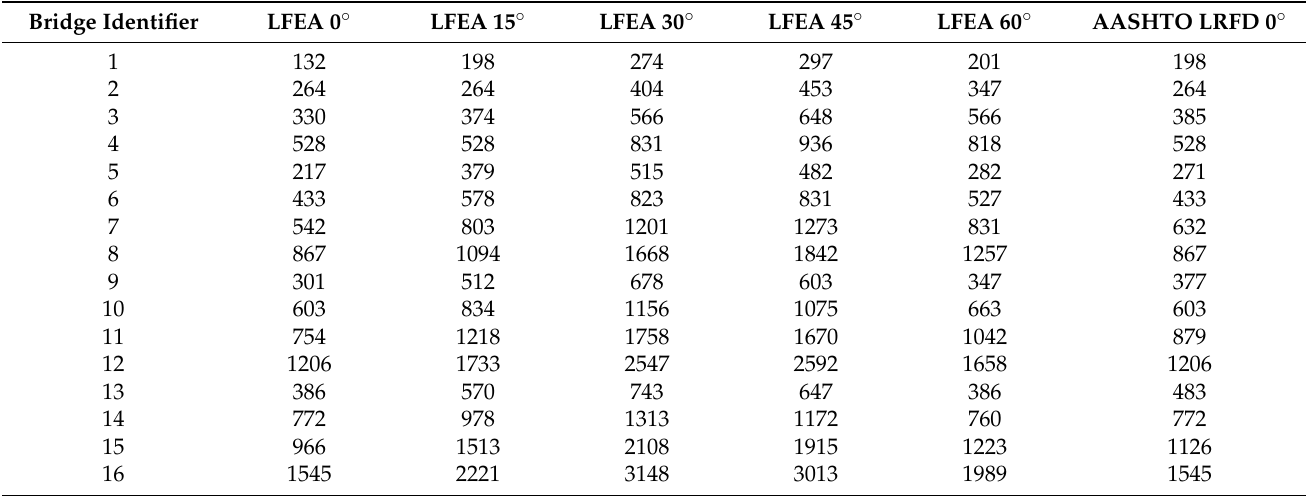
Table 9. Weight (in kg) of steel reinforcement for bending moment—transverse reinforcement. Bridge identifiers are explained in Table 7.